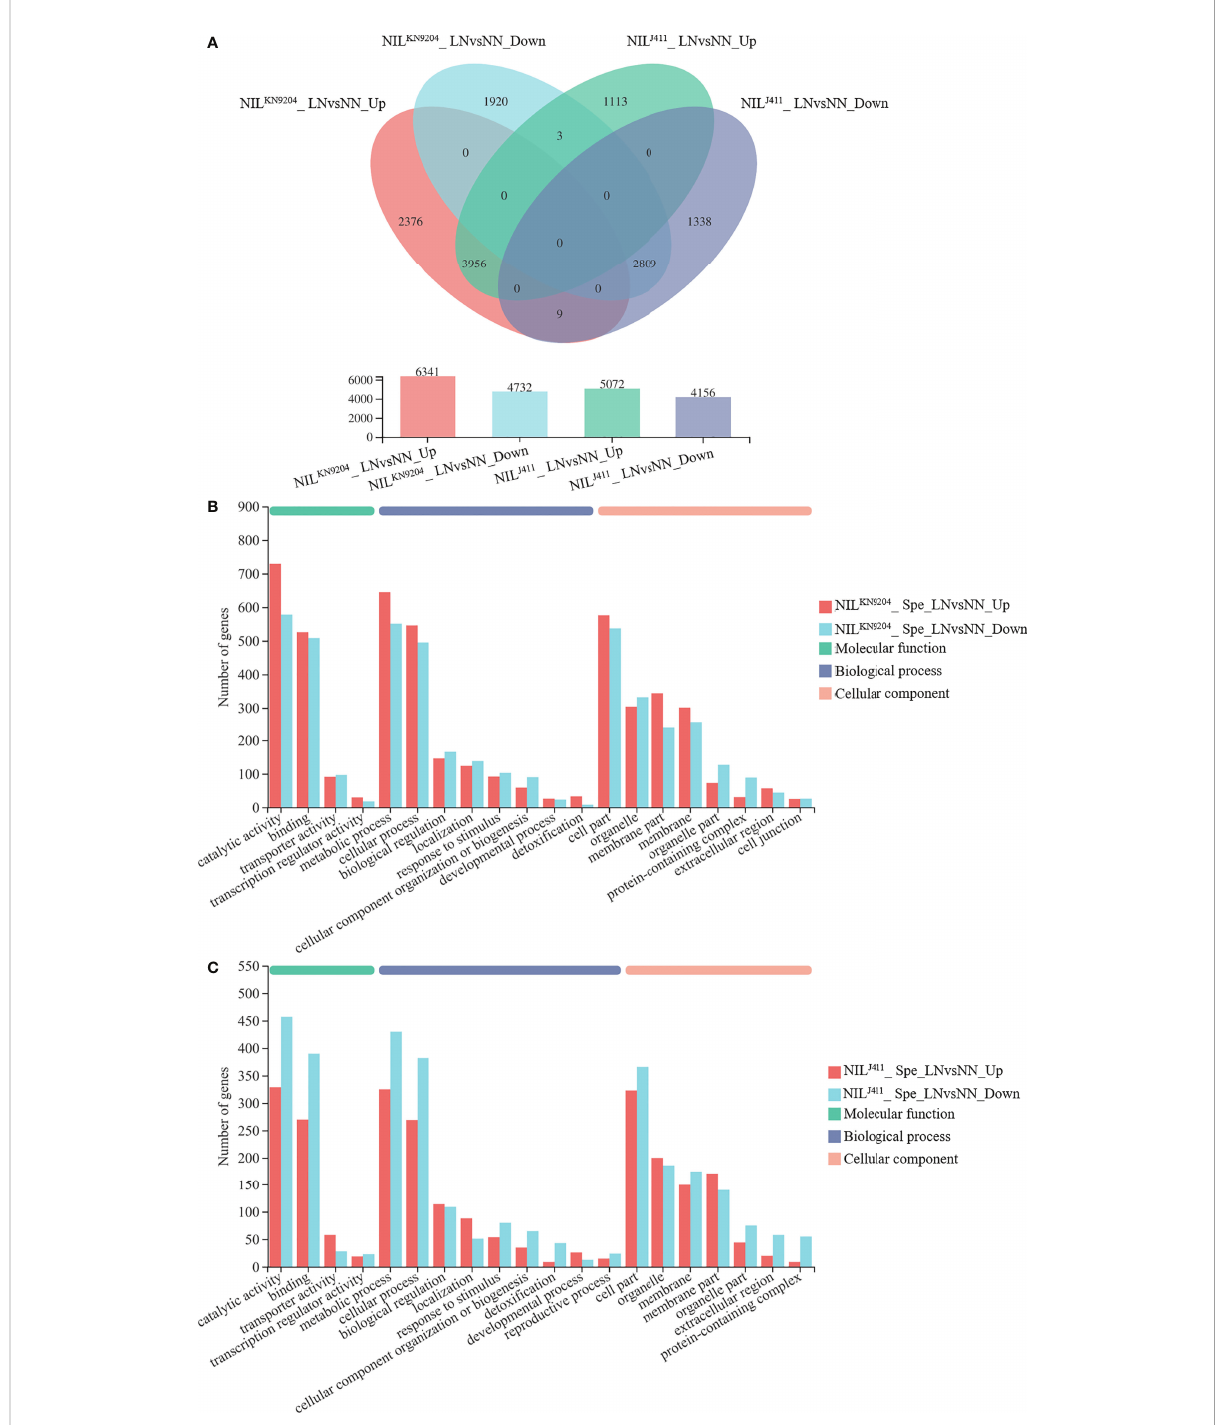
FIGURE 3 Identi fi cation of DEGs induced by LN NN and LN indicate normal- and low-nitrogen conditions, respectively. Spe indicates DEGs speci fi cally expressed in the NIL KN9204 or the NIL J411 . The expression levels between NN and LN conditions were compared for each NIL, with NIL KN9204 as a control. LN vs NN_Up and LN vs NN_Down indicate DEGs whose expression was upregulated and downregulated under LN compared to NN for the same NIL. (A) Venn diagram analysis of the DEGs in each one-to-one comparison between NN and LN conditions for both the NIL KN9204 and NIL J411 . (B, C) GO annotation analysis of the genes whose expression differed speci fi cally in the NIL KN9204 (B) and NIL J411 (C) with the fi rst 20 terms as